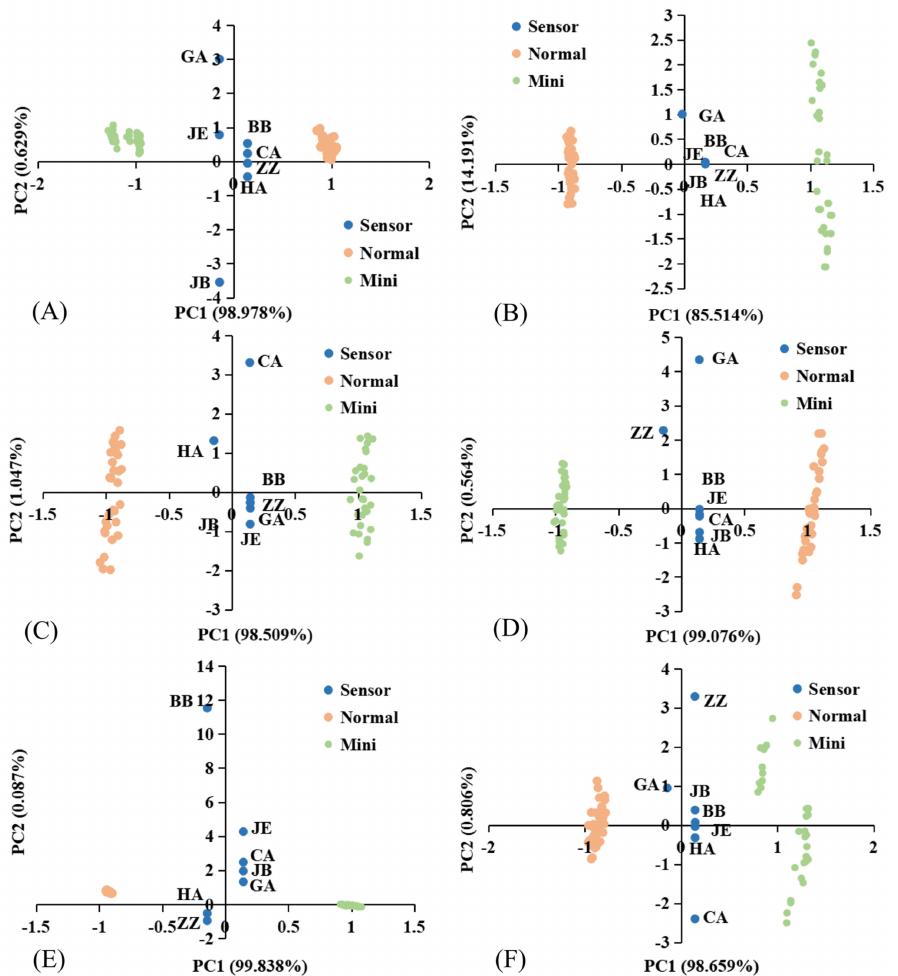
Figure 7. E-tongue PCA score charts of MFV and NFV: ( A ) watermelon; ( B ) pineapple; ( C ) pumpkin; ( D ) cabbage; ( E ) maize; ( F )